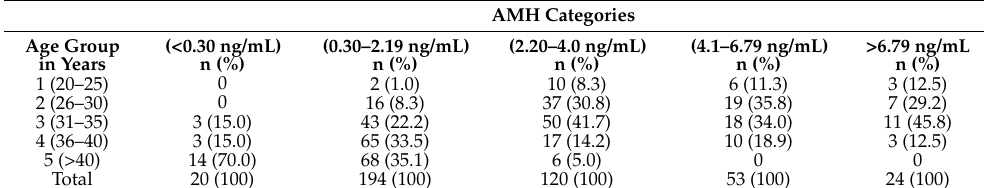
Table 2. Comparison of serum levels of AMH groups and maternal age categories.